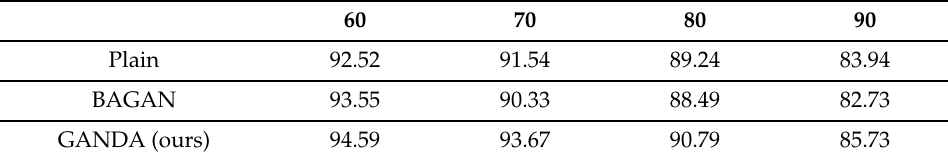
Table 5. The average accuracy (%) of the minority class achieved by the ResNet-18 classifier trained with an augmented subset of the CelebA dataset whose balance is restored after removing a portion of the minority class